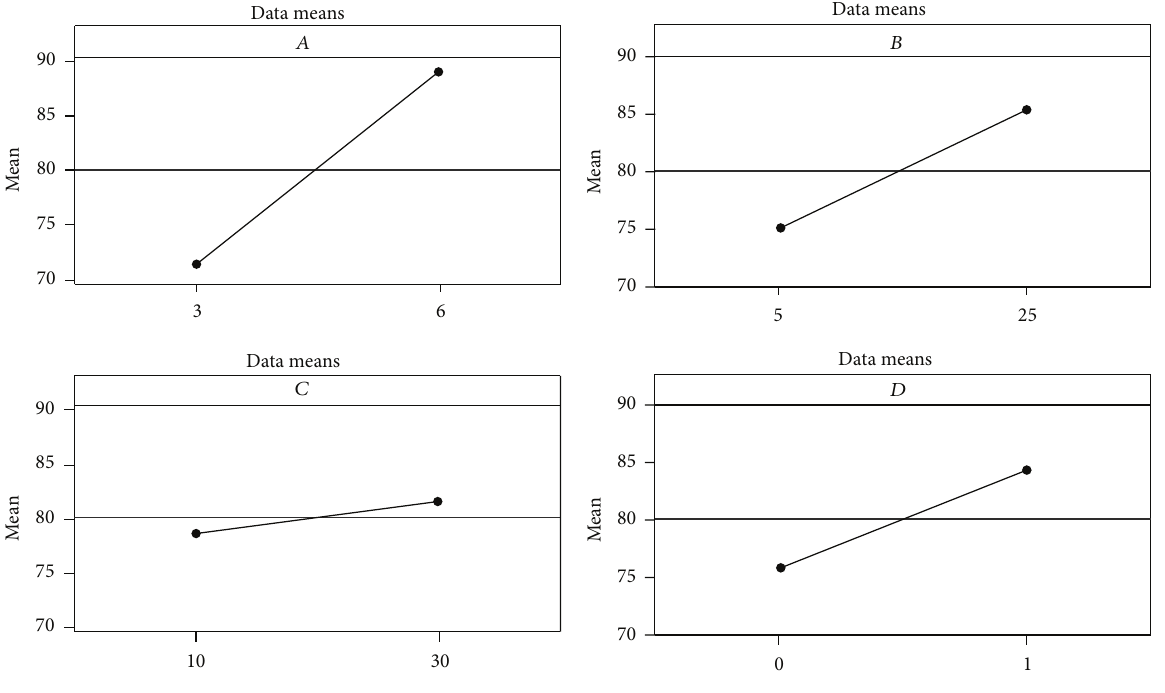
Figure 2: Main effects plot for removal efficiency.